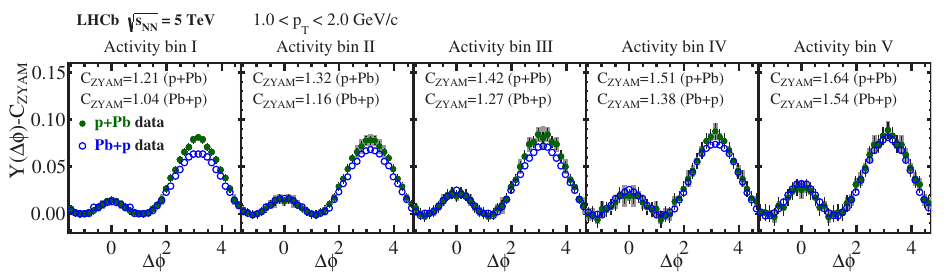
Figure 2. 1D yield from correlation function integration. The ZYAM normalization method is applied. An emergence of long-range near-side correlations can be observed in high activity events. Figure 1. Correlation functions for Pb p collisions at low (left) and high (right) activity.